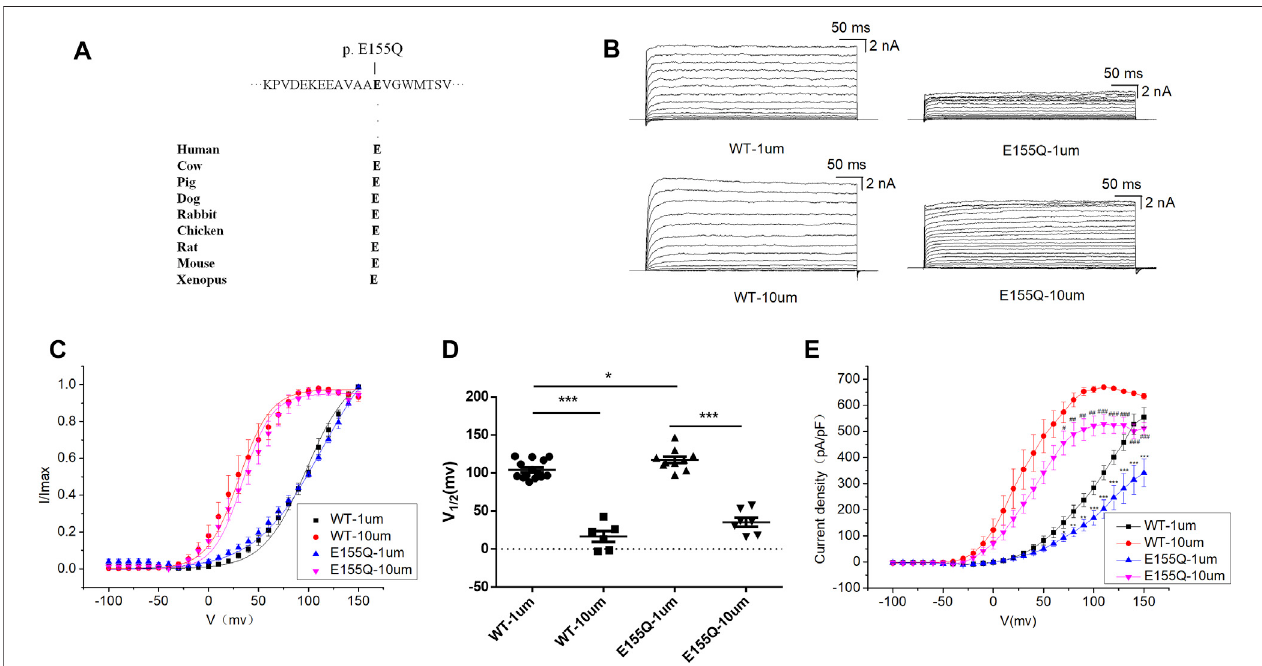
FIGURE 2 | Electrophysiological characterization of variant E155Q. (A) The E155Q variant occur at an evolutionarily conserved amino acid residues. (B) Representative macroscopic currents of WT and mutant BK channels with variant E155Q from whole-cell patch experiments in the presence of 1 and 10 μ m Ca 2+ . (C) The I-V curves of WT and E155Q mutant BK channels are shown at 1 and 10 μ m Ca 2+ . The I-V curves are fi tted by Boltzmann function (solid lines) with V1/2 and slope factor at nominal at 1 μ m Ca 2+ [97.5 ± 4.1 mV, 21.4 ± 2.1 WT, and 113.4 ± 6.4 mV, 33.2 ± 3.3 p.(E155Q)] and at 10 μ m Ca 2+ [30.4 ± 2.4 mV, 15.9 ± 0.8 WT, and 34.2 ± 2.9 mV,14.6 ± 1.6p.(E155Q)]. (D) Scatterplotsofvoltageathalf-maximalactivation(V1/2)forWTand variants. (E) Thecurrentdensity ofWTand E155Qmutant BKchannelsareshownat1and10 μ mCa 2+ .Thedataarepresentedasmean ± SEM.(ComparedwithWT-1um,* p < 0.05,** p < 0.01,*** p < 0.001.ComparedwithWT- 10um, # p < 0.05, ## p < 0.01, ### p < 0.001. n (cid:2) 6 –